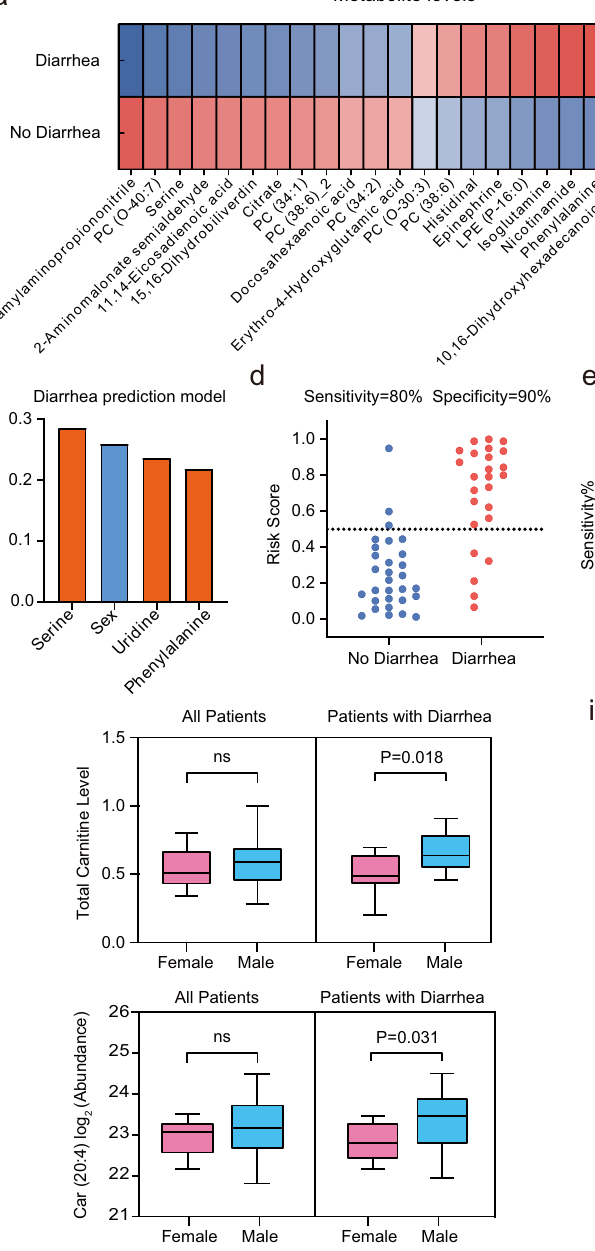
Fig. 2 | Acyl carnitinesare linkedtosex disparity in diarrhea inducedbynCRT. a Pre-therapeutic metabolites in baseline were signi fi cantly associated with diar- rhea of LARC patients ( P <0.05; Two-sided Wilcoxon test). All metabolites were corrected by the covariate of sex using a linear model. b Pathway enrichment analysis ( P <0.05; Hypergeometric test). c Selected key metabolites and the cov- ariate of sex for the logistic regression model to predict the chance of diarrhea. d Sensitivity and speci fi city of the prediction model with the risk score of 0.5 (Diarrhea: n =25; No diarrhea: n =30). e Receiver operating characteristic curve of